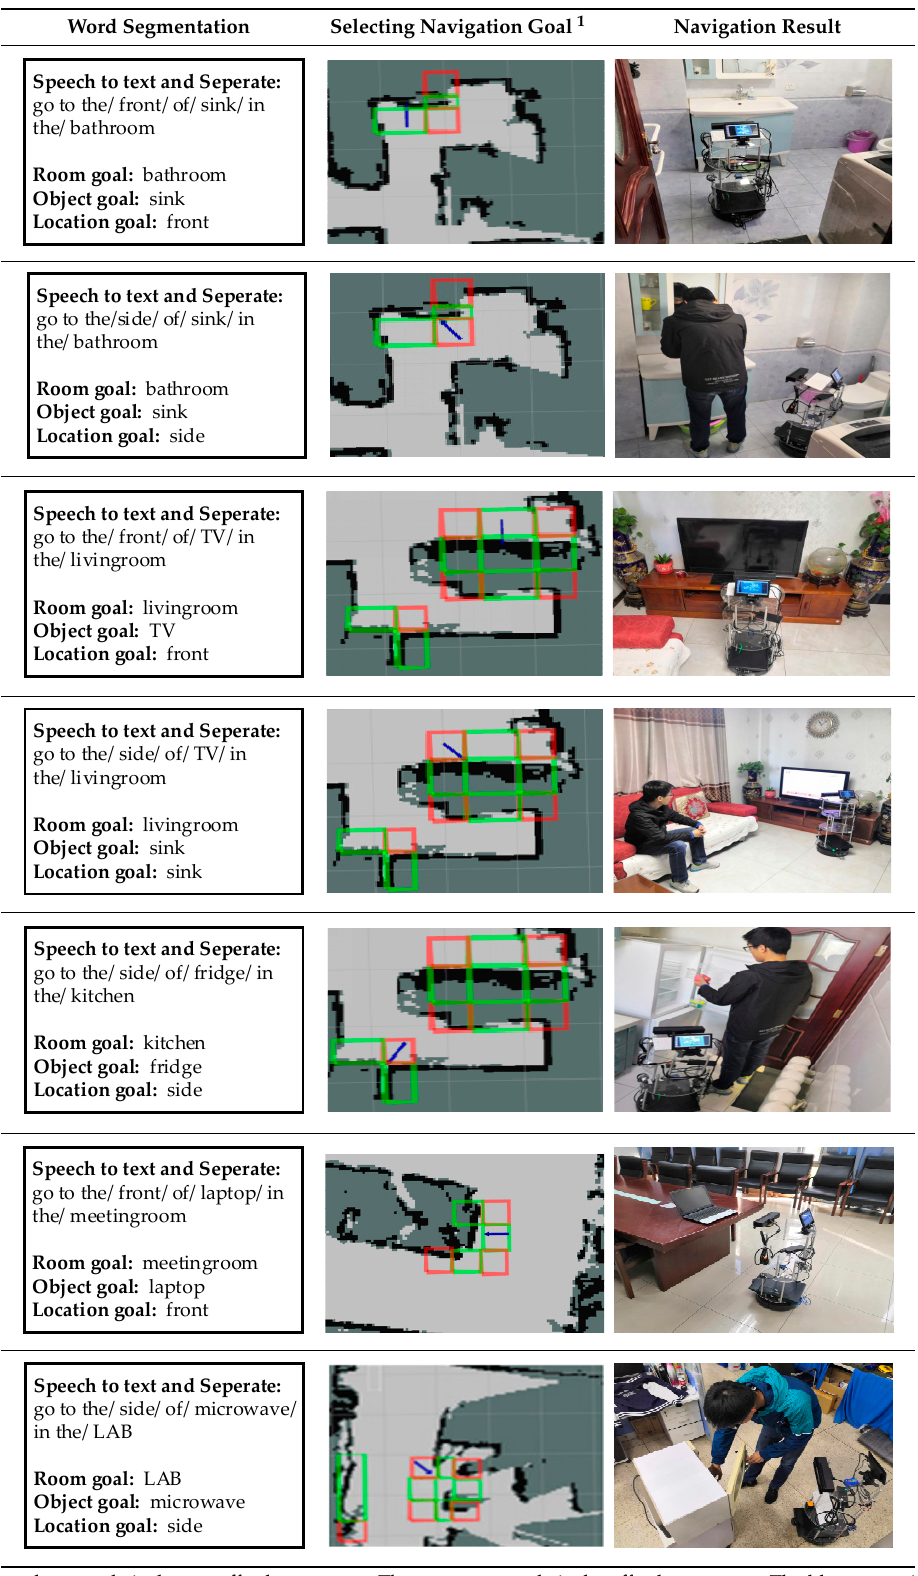
Table 3. Experiment results of automatically selecting navigation goal.